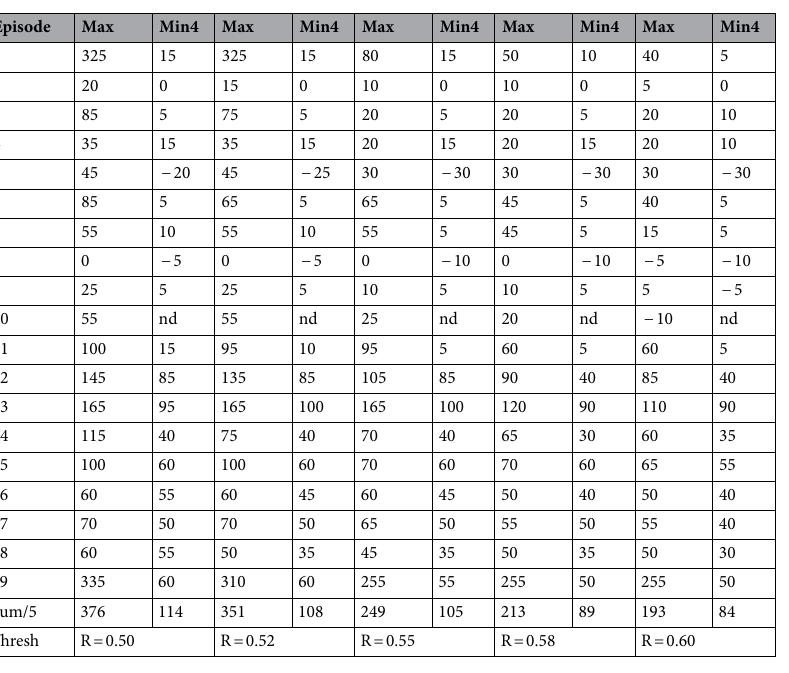
Table 3. Comparison of lead times (given in minutes) for various thresholds of the R value for the 19 lava fountain episodes from January 1 to April 1, 2021. Sum/5 is the sum of the lead times expressed in terms of the number of the patterns, each of which covers 5